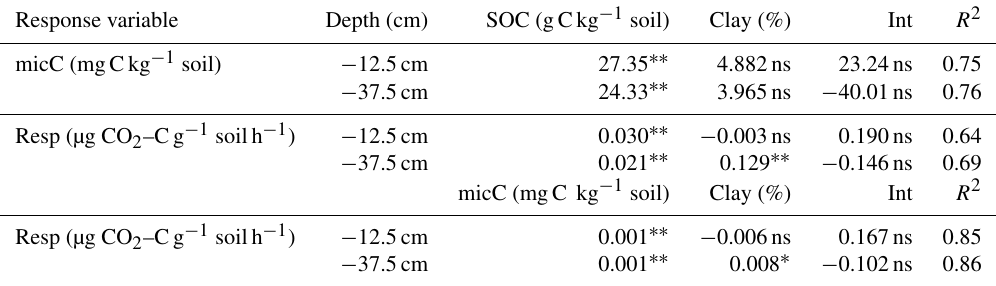
Table 5. Summary statistics of multiple linear regression models to explain microbial biomass and soil microbial respiration as a function of soil organic carbon content, microbial biomass, and clay content (Eq. 4). ∗∗ and ∗ indicate significant regression coefficients at p< 0 . 01 and p< 0 . 05, and ns indicates non-significant regression coefficients. R 2 represents multiple r -squared values. Response